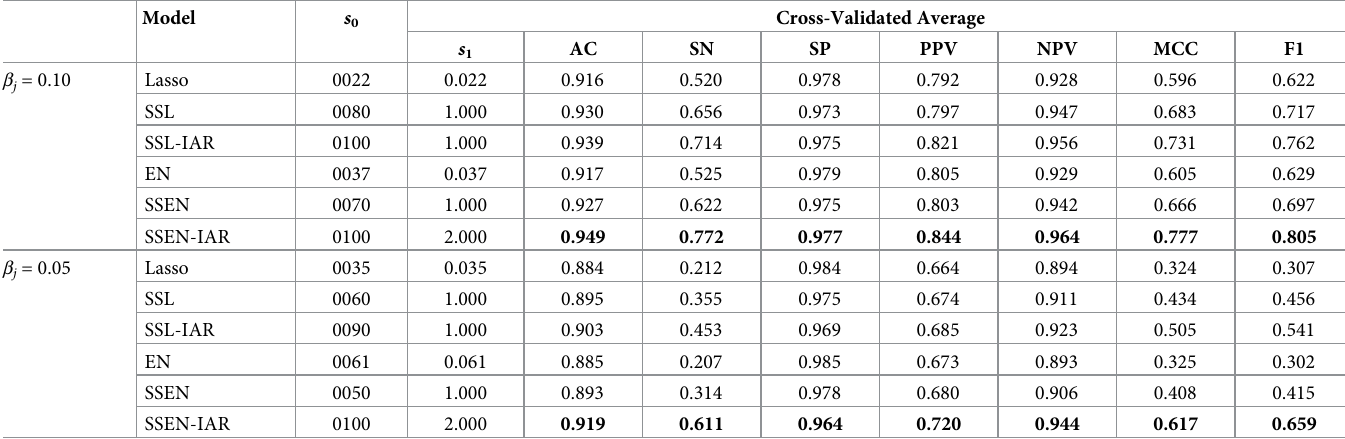
Table 4. Simulation study: Average classification performance. Model